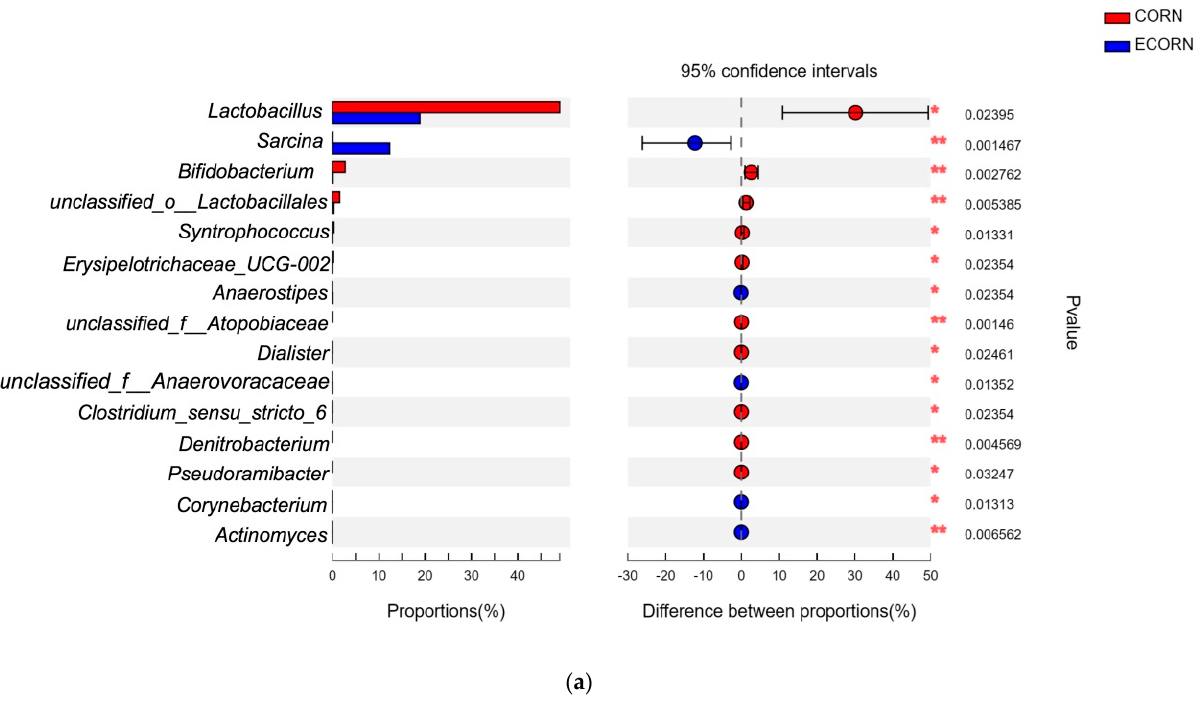
Figure 6. Analysis for differential bacteria at the family level among 4 dietary treatments. Treatments